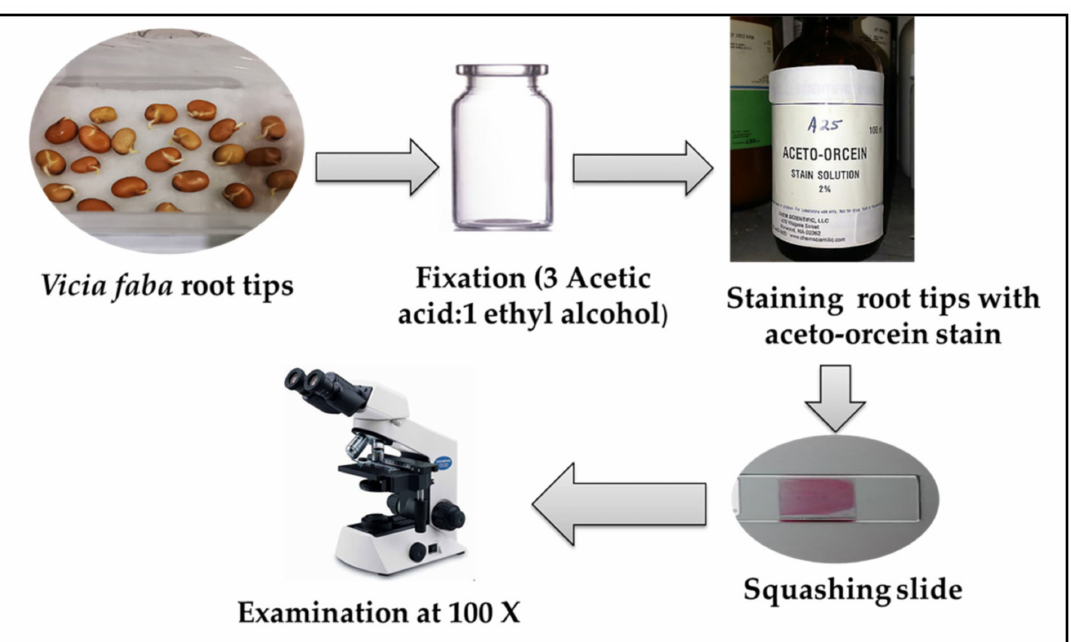
Figure 14. Diagrammatic scheme for preparation of chromosomal aberrations